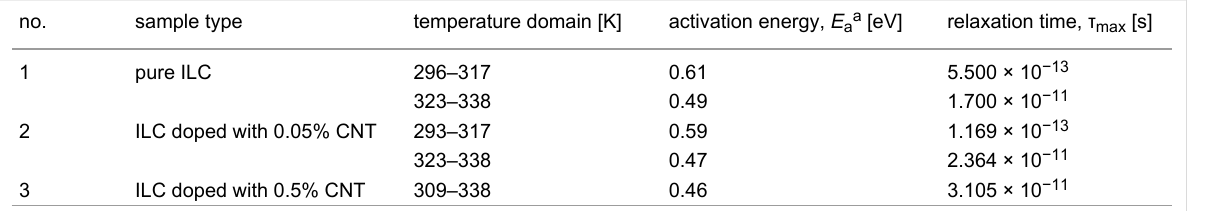
Table 1: DS characteristic constants for pure and CNT-doped ILC.